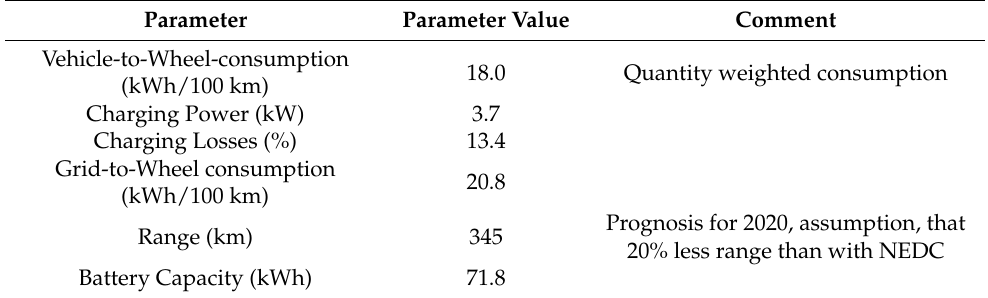
Table A1. Data for the simulation of the mobility and charging load, data source: [30–32].